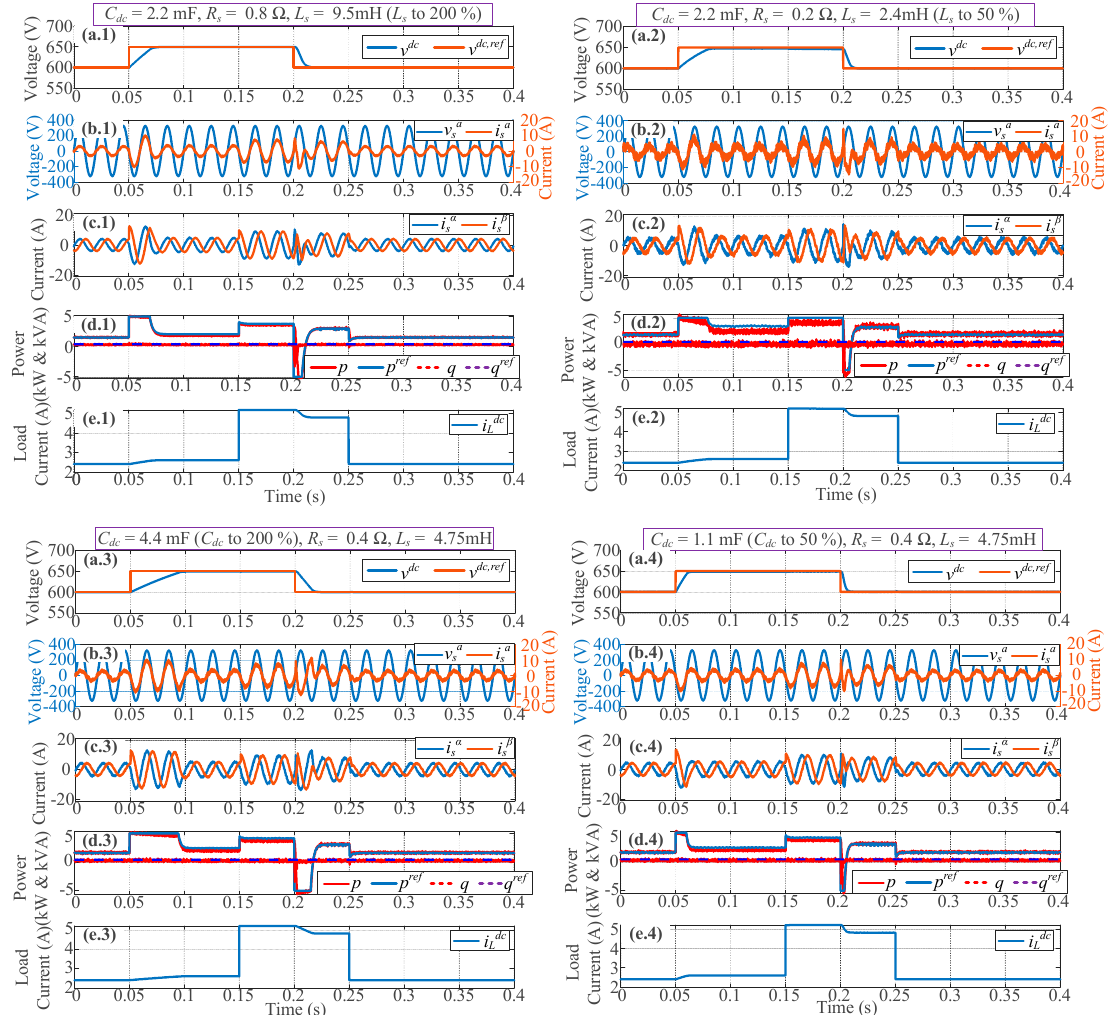
Figure 5. Different parameters, ( a ) dc voltage and reference, ( b ) v s α voltage and i s α current, ( c ) i s αβ currents, ( d ) active p s and reactive q s power, ( e ) load current i Ldc , with ( 1 ) inductances increase to 200%, ( 2 ) inductances decrease to 50%, ( 3 ) capacitor increases to 200%, ( 4 ) capacitor decreases to 50%.